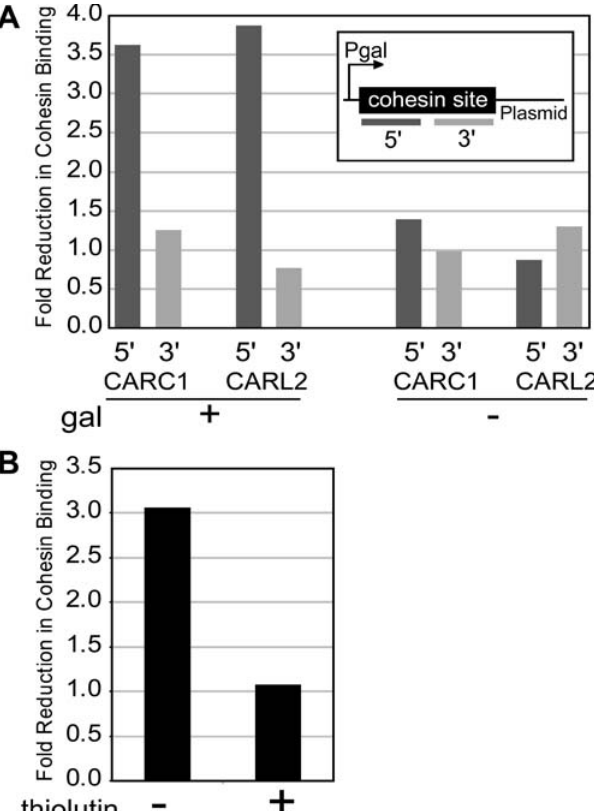
Figure 7. Effect of Transcript Elongation on Cohesin Associated with CARC1 and CARL2 Located on a Plasmid Next to a Galactose-Inducible Promoter (A) The fold reduction in cohesin binding in the presence ( þ ) or absence ( (cid:1) ) of galactose-induced transcription is depicted as a function of the 5 9 or 3 9 end of the locus. (B) The fold reduction in cohesin binding at CARL2 during galactose- induced transcription in the presence ( þ ) or absence ( (cid:1) ) of thiolutin, an inhibitor of transcript elongation. DOI: